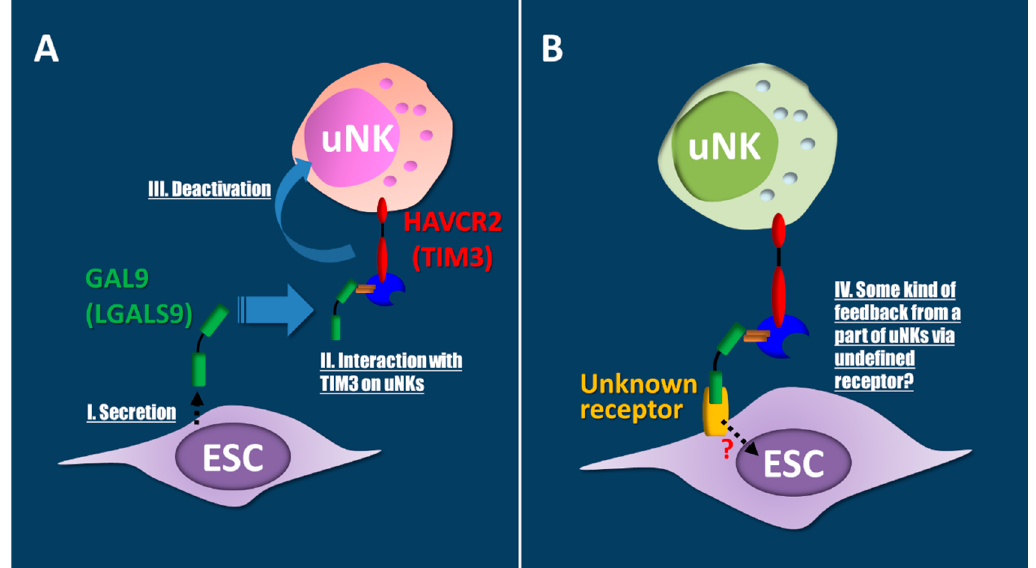
Figure 5. Endometrial stromal cells (ESCs) may be regulated by a Hepatitis A virus cellular receptor 2 (HAVCR2)- galectin 9 (GAL9) interaction via unknown receptors on ESCs. ( A ) Decidual ESCs increase secretion of the ligand GAL9 (I). Secreted GAL9 interacts with HAVCR2 on uterine natural killer (uNK) cells (II). These interactions induce the deactivation of uNKs (III). As a result, immune tolerance, apoptosis, and eliminations may occur, similar to that in Th1-macrophage interactions. ( B ) Feedback regulations of the HAVCR2-GAL9 interaction via known or unknown membrane proteins are suggested in ESCs through uNKs (IV).